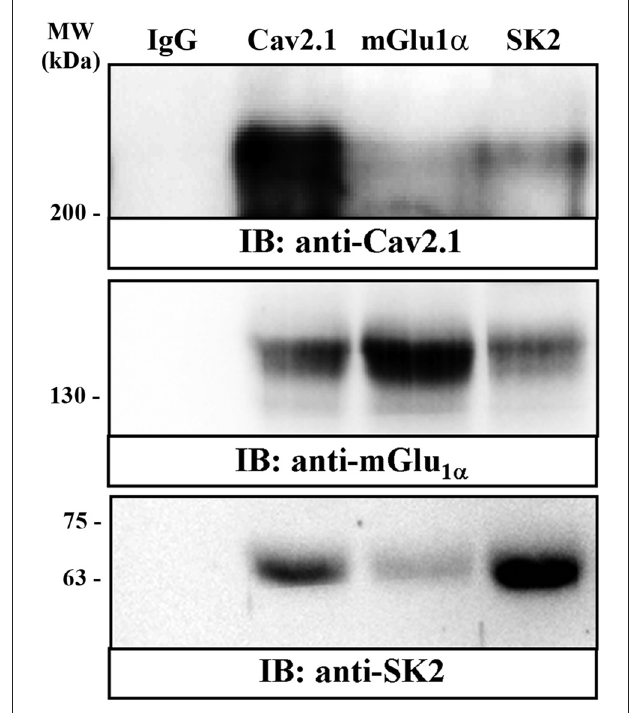
FIGURE 4 | Co-immunoprecipitation of mGlu 1 α receptor and SK2 and Cav2.1 channels from mouse cerebellum. Solubilized cerebellar membrane extracts underwent immunoprecipitation analysis using rabbit control IgG (2 µ g, lane 1); rabbit anti-Cav2.1 (2 µ g, lane 2); rabbit anti-mGlu 1 α (2 µ g, lane 3) and rabbit anti-SK2 (2 µ g, lane 4). Immunoprecipitates (IP) were investigated by SDS-PAGE and immunoblotted using a rabbit anti-Ca V 2.1 (1 µ g/ml), rabbit anti-mGlu 1 α (1 µ g/ml) and guinea-pig anti-SK2 (1 µ g/ml). Immunoreactive bands were detected as we have described in detail in the experimental